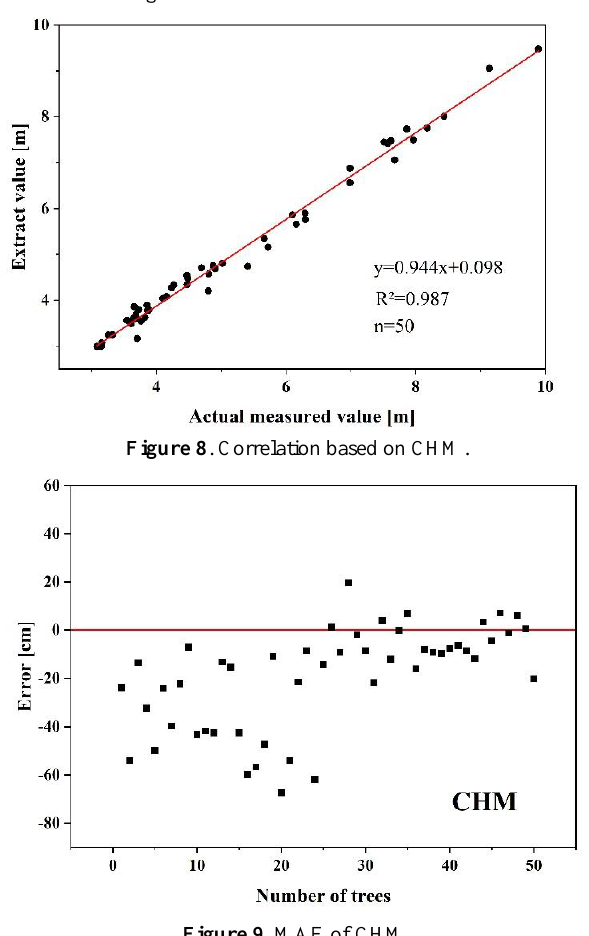
Figure 10 . Correlation based on Point Cloud.